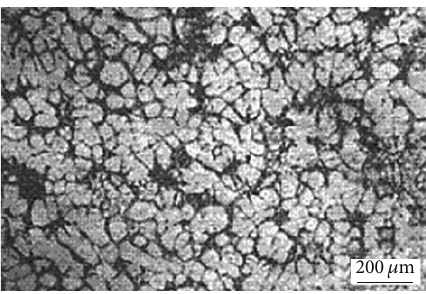
Figure 25: Microstructure of 390 aluminum alloy obtained by ultrasonic vibration [53].